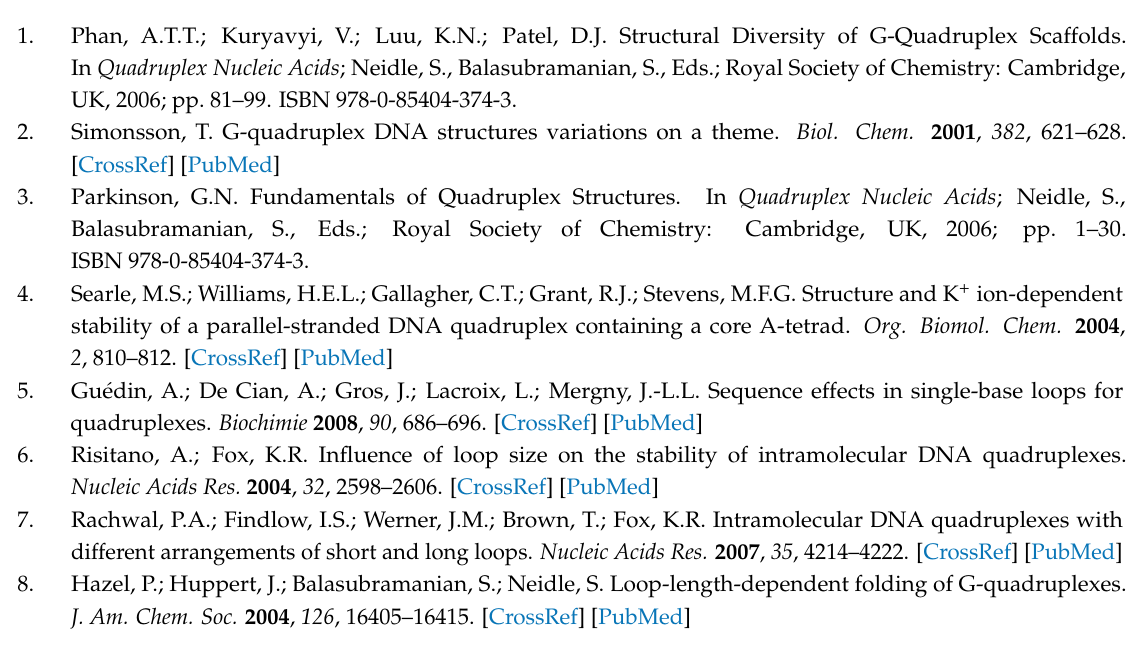
Supplementary Materials: The following are available online, Figure S1: CD spectra of samples annealed in buffer, Figure S3: imino protons region of 1 H-NMR spectrum of (TG 4 T) 4